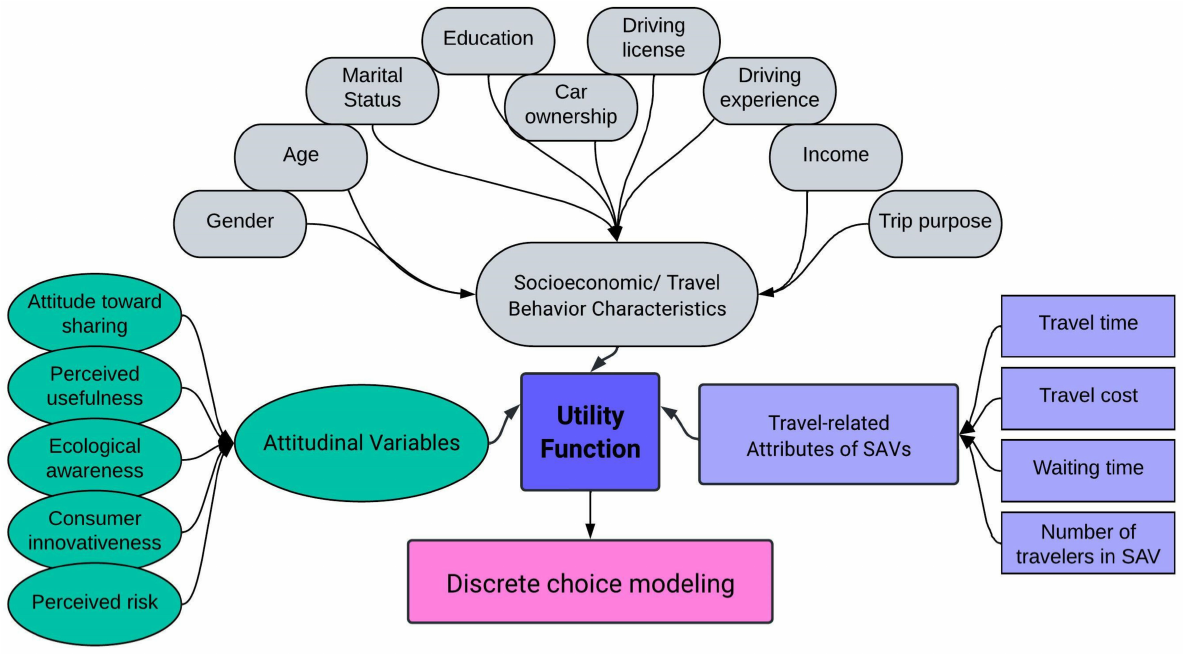
Figure 1. Conceptual model framework for assessing the modal shift preference to SAVs with